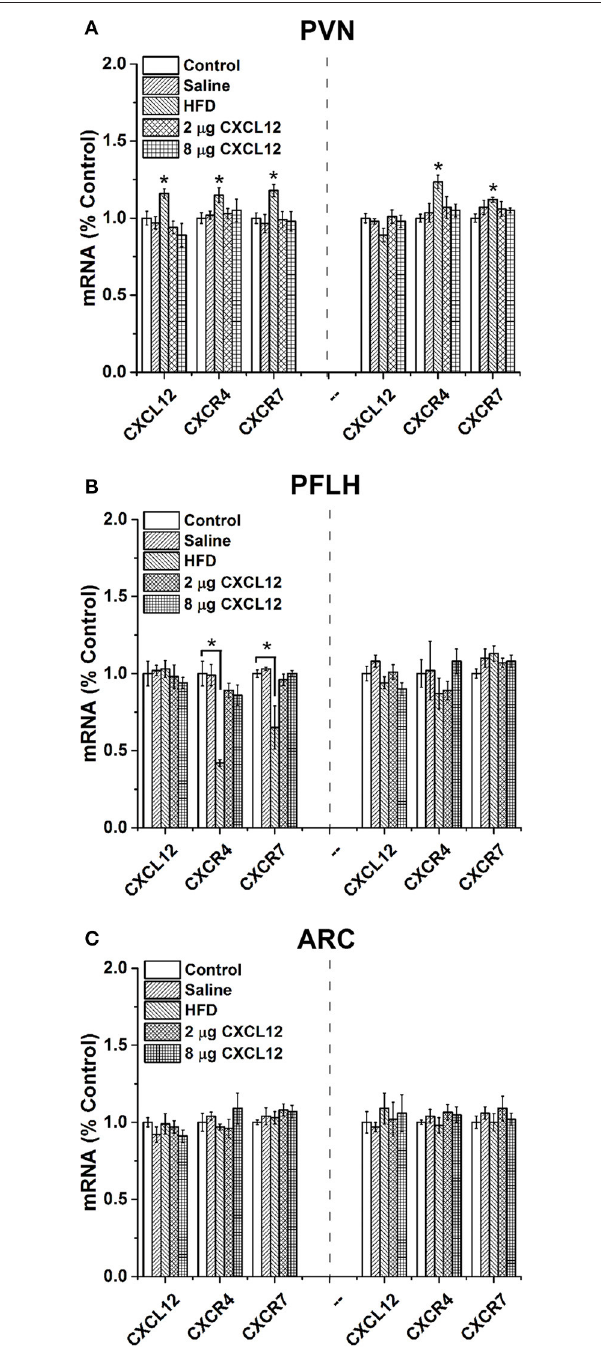
FIGURE 2 | Prenatal HFD affects CXCL12 chemokine system in the hypothalamus of offspring. The graphs represent the expression of CXCL12, CXCR4, and CXCR7 at postnatal day 15 (P15) (left) and P30 (right). (A) In the paraventricular nucleus (PVN), a significant increase of CXCL12, CXCR4, and CXCR7 was found with prenatal HFD exposure at both P15 and P30, with no effect seen with 2 or 8 µ g CXCL12 or saline as compared to control. (B) In the perifornical lateral hypothalamus (PFLH), a significant decrease in CXCR4 and CXCR7 was found with prenatal HFD at P15, with